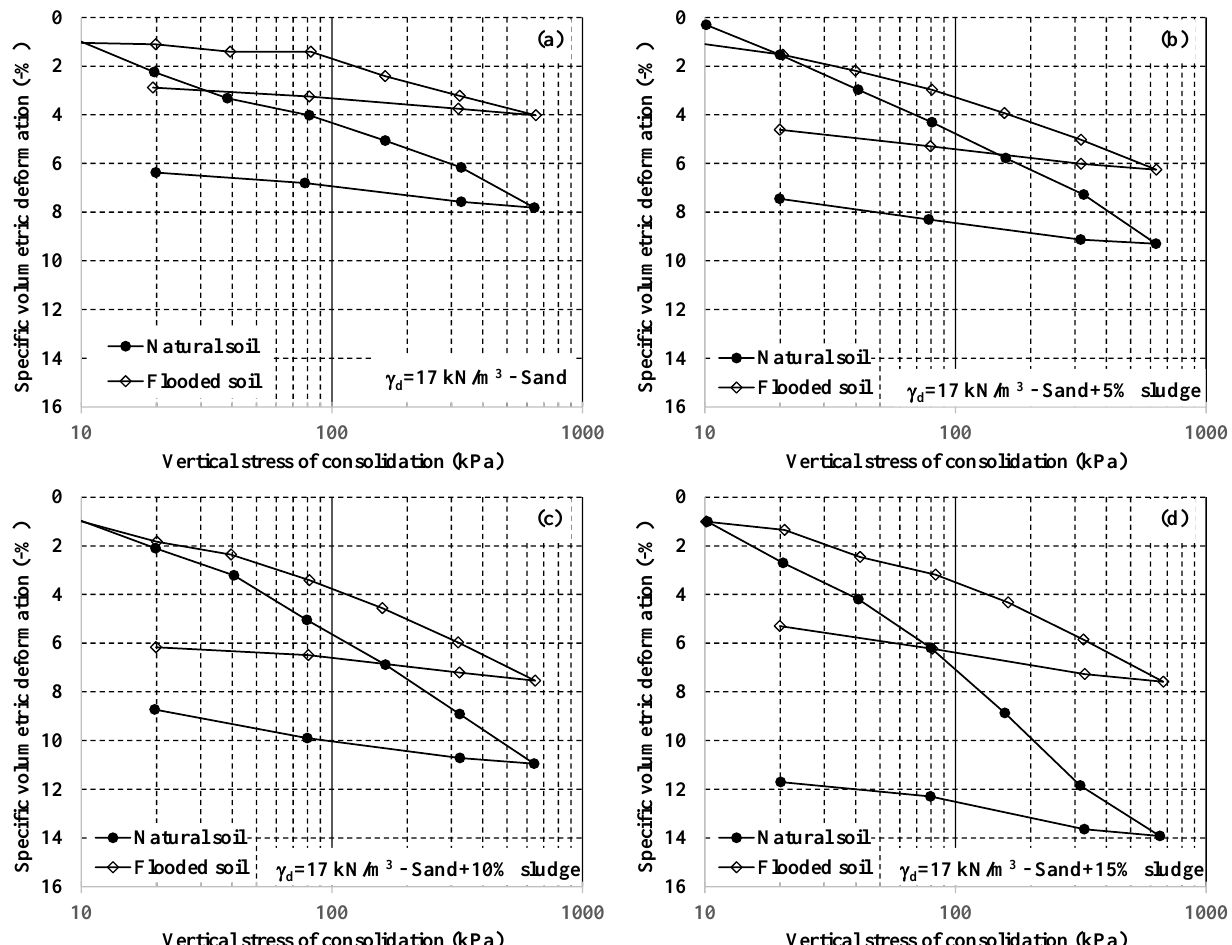
Figure 16. Variation of specific volumetric deformation with the vertical consolidation stress obtained through double oedometer tests, for dry apparent specific weight of 17.0 kN/m 3 : ( a ) sand, ( b ) sand plus 5% sewage sludge, ( c ) sand plus 10% sludge, ( d ) sand plus 15% sludge. For the dry apparent specific weight of 15.0 kN/m 3 , the pre-consolidation stress in the non-flooded soil increased with the addition of sludge to the soil up to 5% and then decreased, for the higher sludge contents. In the flooded soil, the pre-consolidation stresses higher sludge